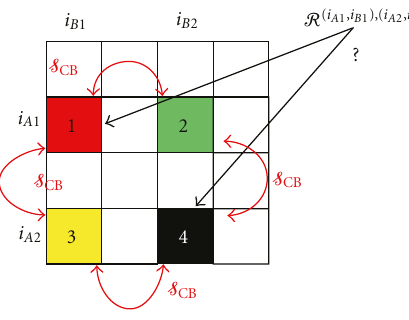
Figure 12: Impact of E-PHXC design criteria on noncritical ( R k , l / ∈ S CB )